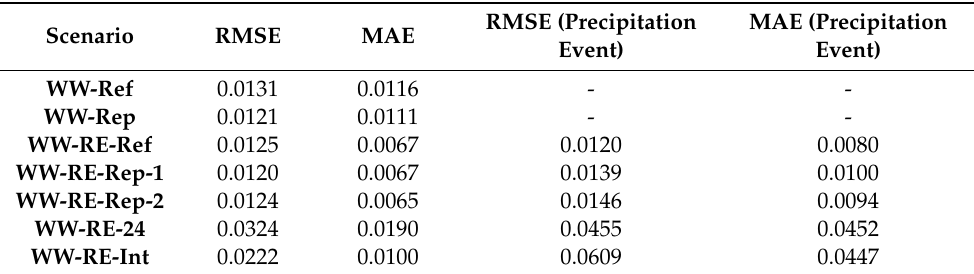
Table 7. Model fit to observation regarding water content (cm 3 cm − 3 ), jointly calculated over the total simulation time and the time most influenced by the precipitation event over all observation points P1–P7, respectively, for separated ditches scenarios “sep.” RMSE (Precipitation MAE (Precipitation Scenario RMSE MAE Event) Event) WW-Ref 0.0131 0.0116 - - WW-Rep 0.0121 0.0111 -